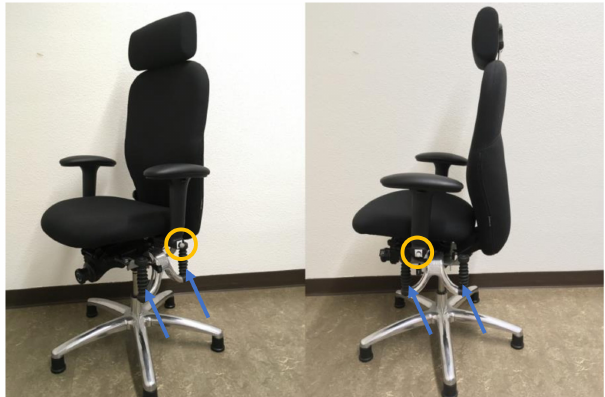
Figure 1. The dynamic swing system is located beneath the seat of the office chair (Haider Bioswing, Pullenreuth, Germany). The blue arrows indicate the location of two of four swinging elements. The yellow circles illustrate the location of the reflective markers at the base of the arm rest.